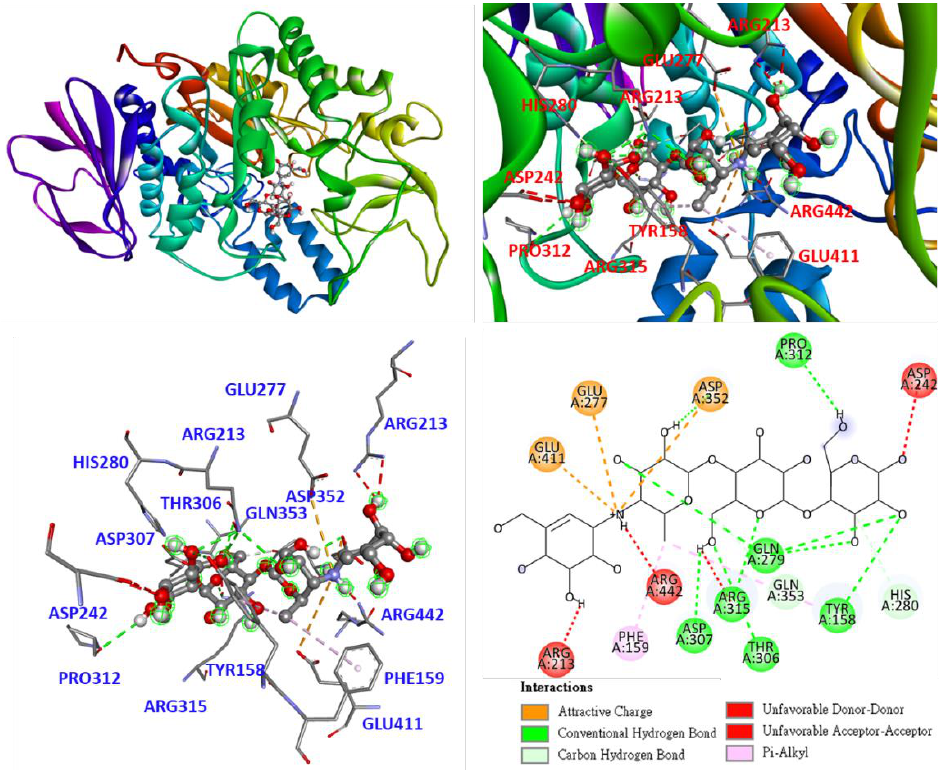
Figure 5. Interaction of acarbose with active sites of S. cerevisiae α -glucosidase.